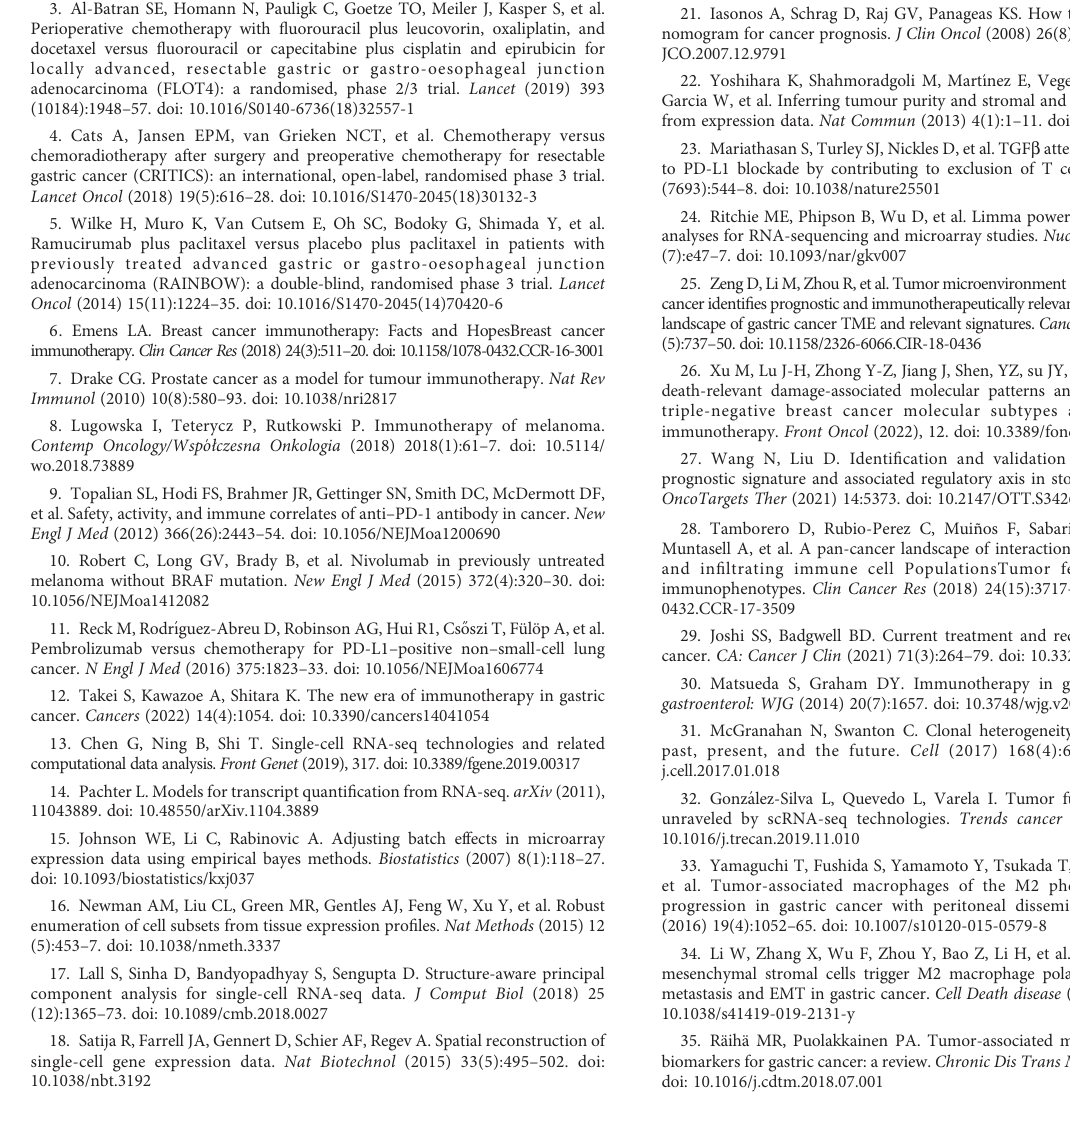
SUPPLEMENTARY FIGURE 4 Differential enrichment of GO annotations between low- and high-risk groups in the external validation cohort.